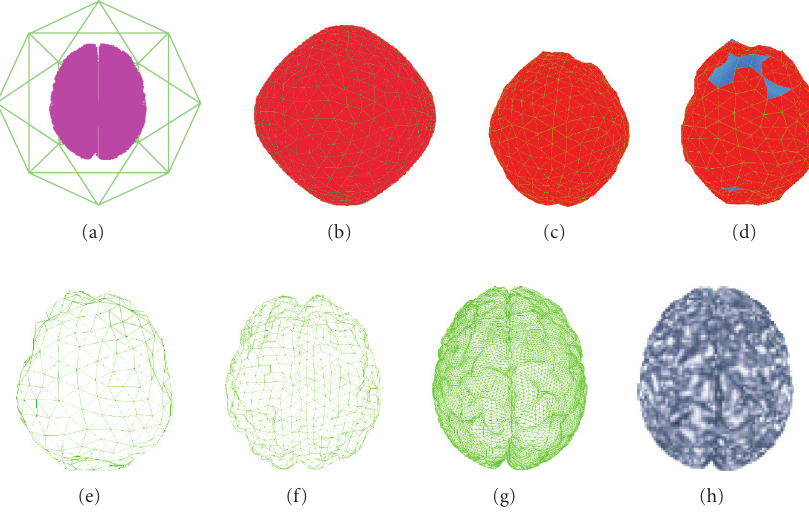
Figure 3: Reconstruction and segmentation of an MRI volumetric dataset of a human brain.